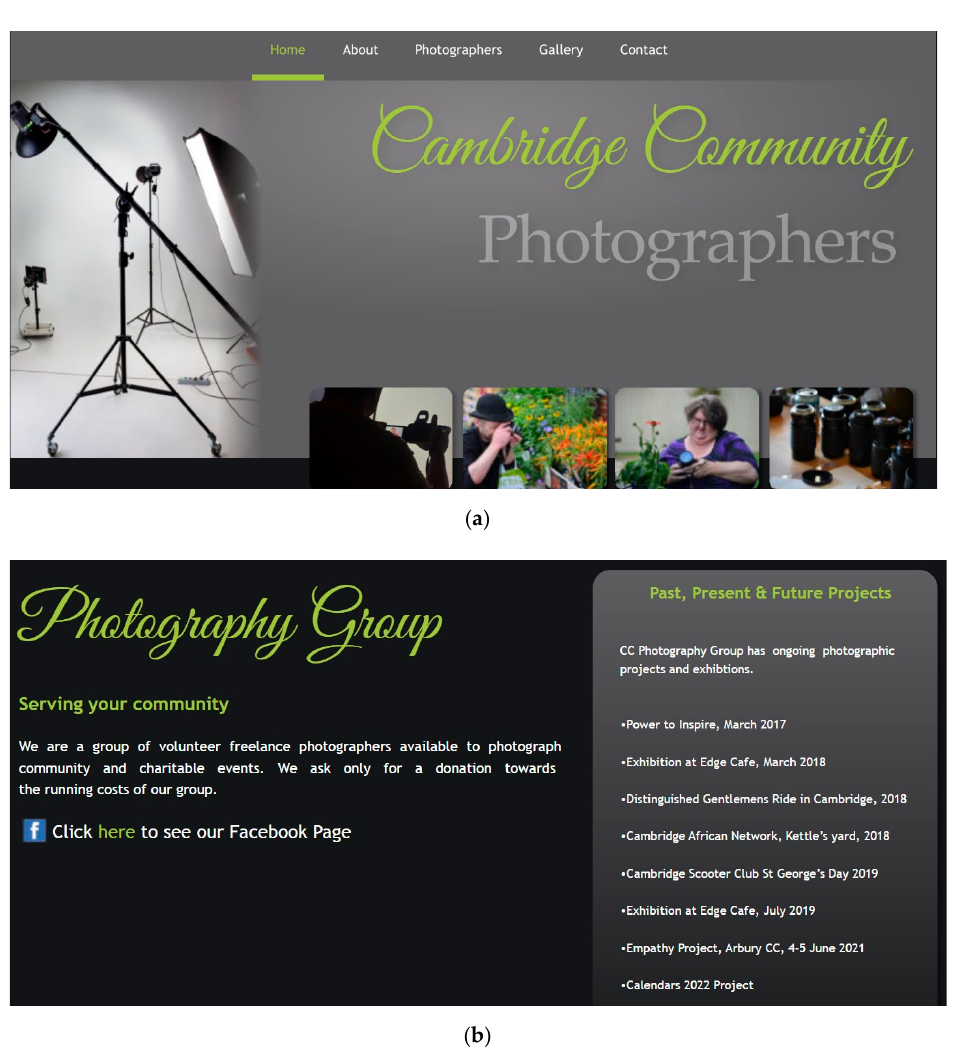
Figure 2. (a) CCA Photography Club Website-1; (b) CCA Photography Club Website-2 Figure 2. ( a ) CCA Photography Club Website-1; ( b ) CCA Photography Club